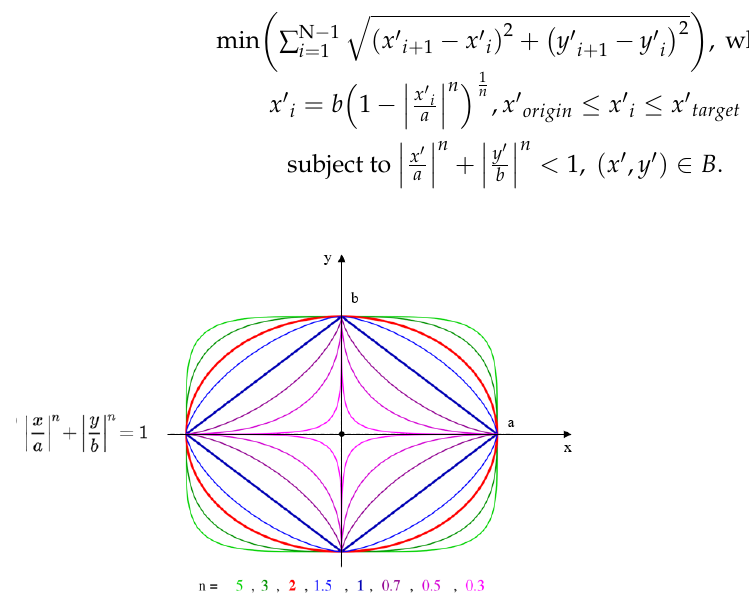
Figure 5. Lamé curve equation and various shapes the curve can take. Figure 5. Lam é curve equation and various shapes the curve can take.